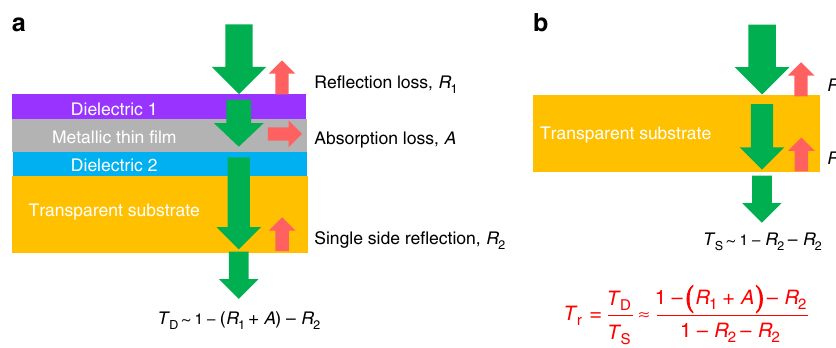
Fig. 1 The de fi nition of relative transmission. a Transparent substrate coated with a DMD structure. b Bare